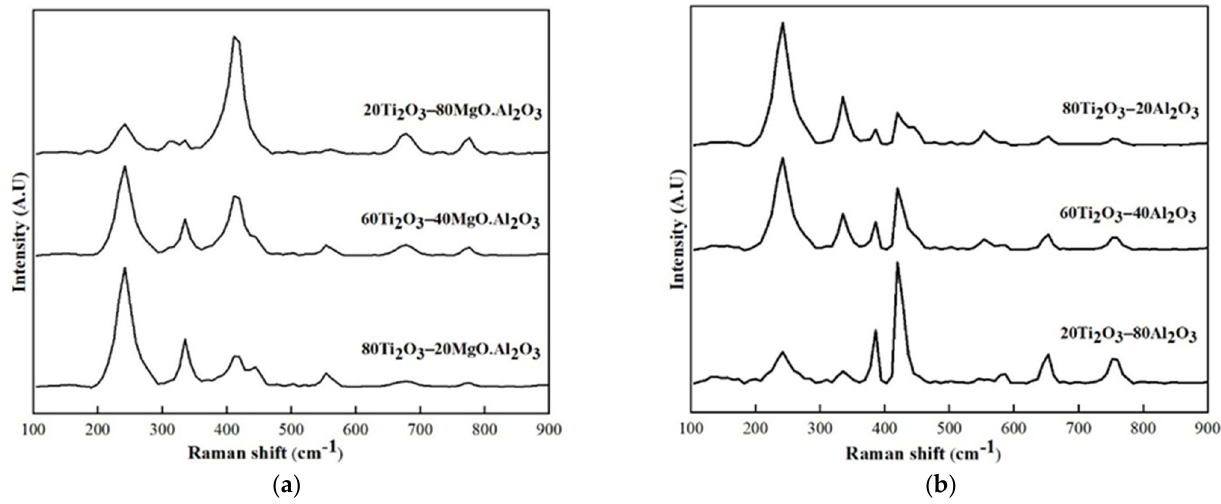
Figure 3. Raman spectra measured from binary samples used to establish a relationship between the phase content and relative peak intensity, where ( a ) is for Ti 2 O 3 –MgO.Al 2 O 3 and ( b ) is for Ti 2 O 3 –Al 2 O 3 .